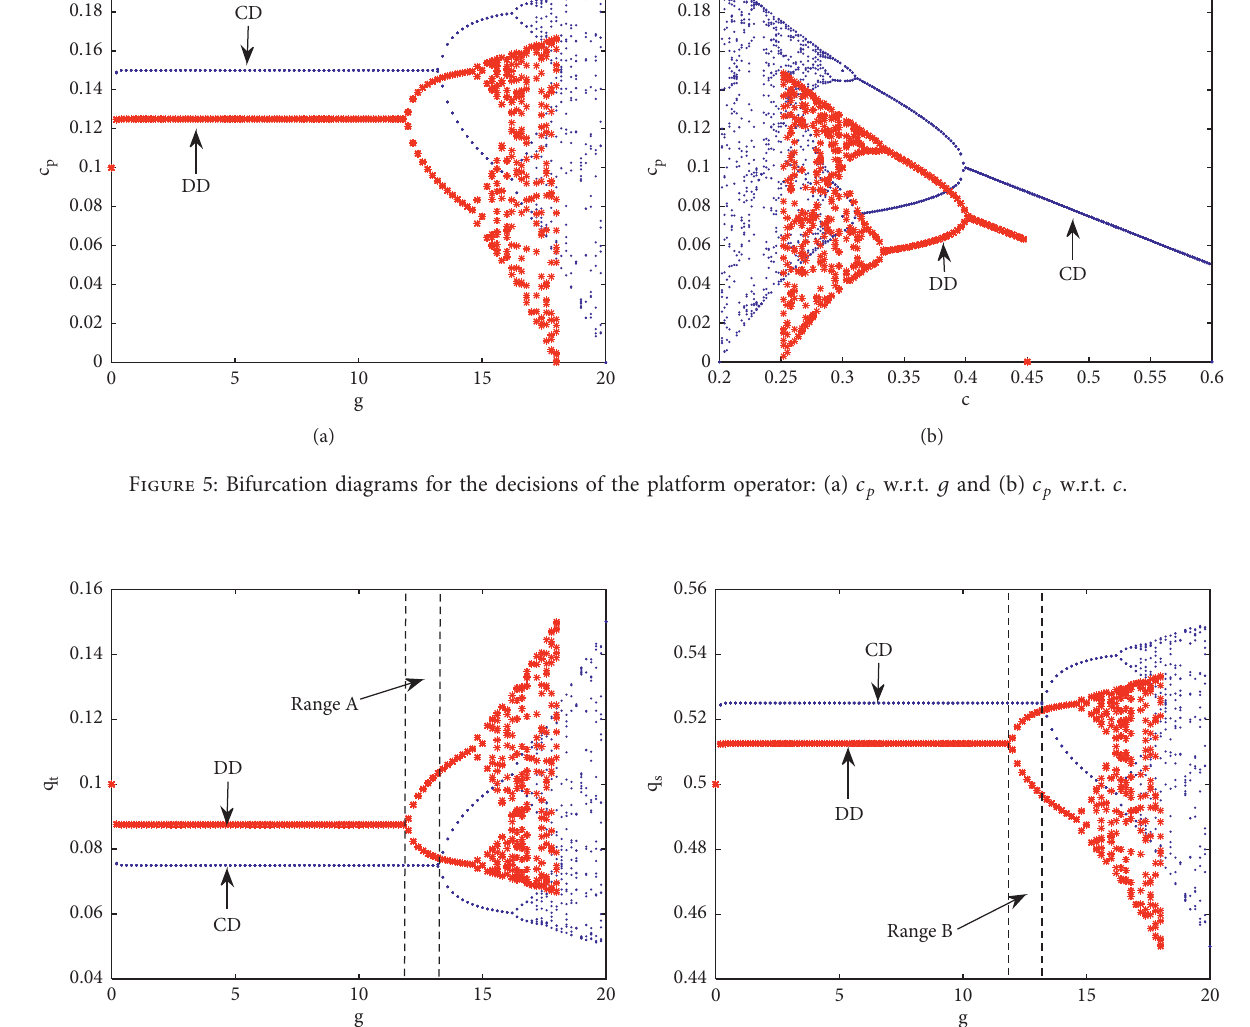
g and (b) q g t w.r.t. s w.r.t.